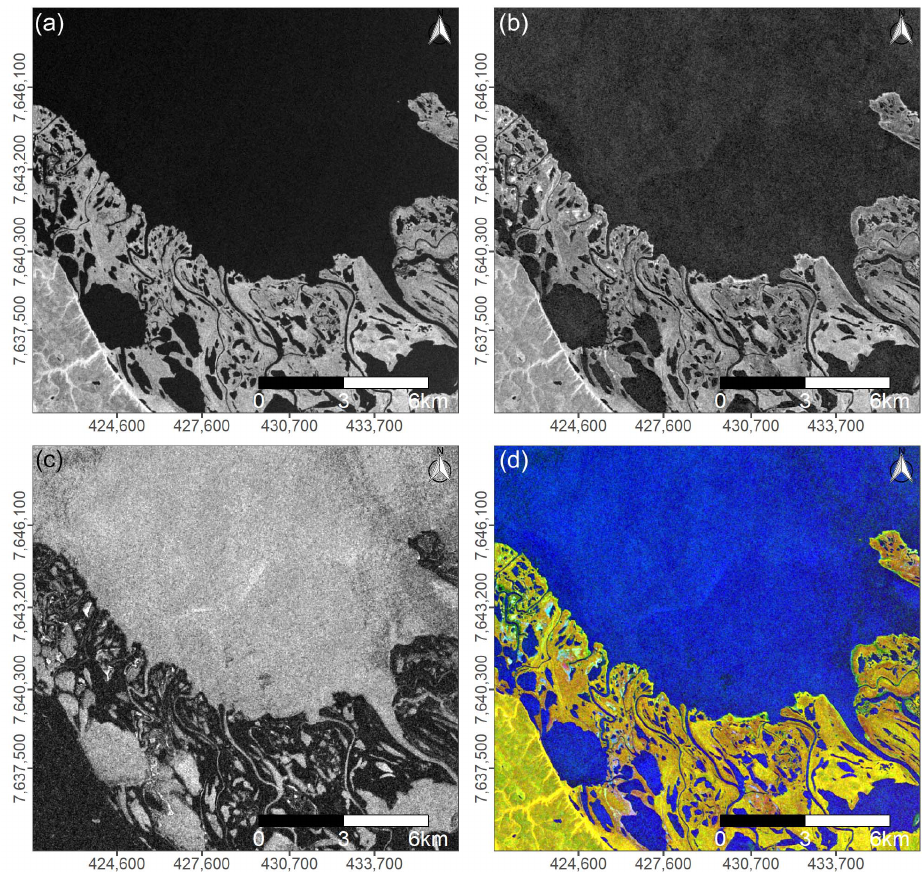
Figure 4. Section of the Shoalwater Bay region in Canada visualized by ( a ) annual median vertical- horizontal (VH) backscatter; ( b ) annual median vertical-vertical (VV) backscatter; ( c ) annual standard deviation (sd) VV backscatter; and ( d ) a pseudo Red Green Blue (RGB) composite of ( a – c ) based on Sentinel-1 (S1) Ground Range Detected (GRD) scenes from the beginning of June until the end